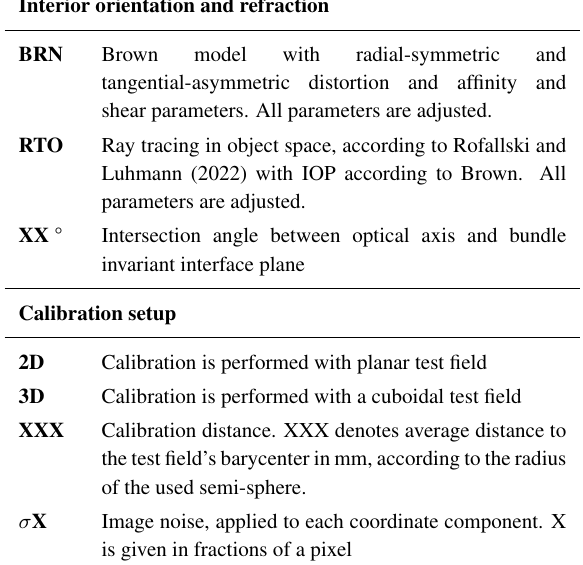
Table 2. Notations for the different simulated configurations Interior orientation and